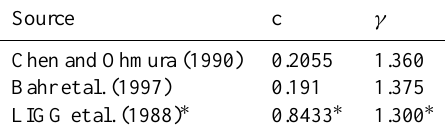
Table 2. Parameters of the applied V–A relations. Cogely (2011) used the same relationships for the glacier volume estimations of the same region. Volumes are calculated in m 3 for input glacier areas measured in m 3 . c is in m 3 − 2 γ , γ is